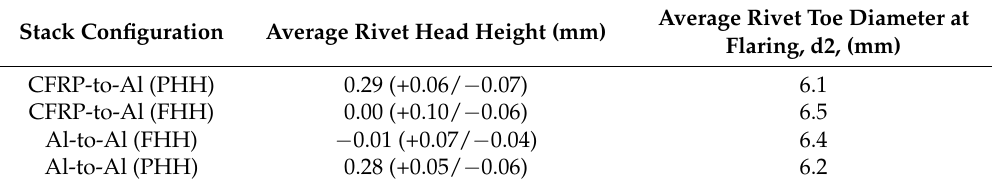
Figure 2. Representative cross-sections of the untested SPR joints: ( a ) carbon-fiber-reinforced polymer (CFRP)-to-Al with proud rivet head height, ( b ) CFRP-to-aluminum with flush rivet head height, ( c ) aluminum-to-aluminum with proud rivet head height, and ( d ) aluminum-to-aluminum with flush rivet head height. Table 1. Stack configuration and geometric values of rivet head height and average diameter of rivet at specific regions.